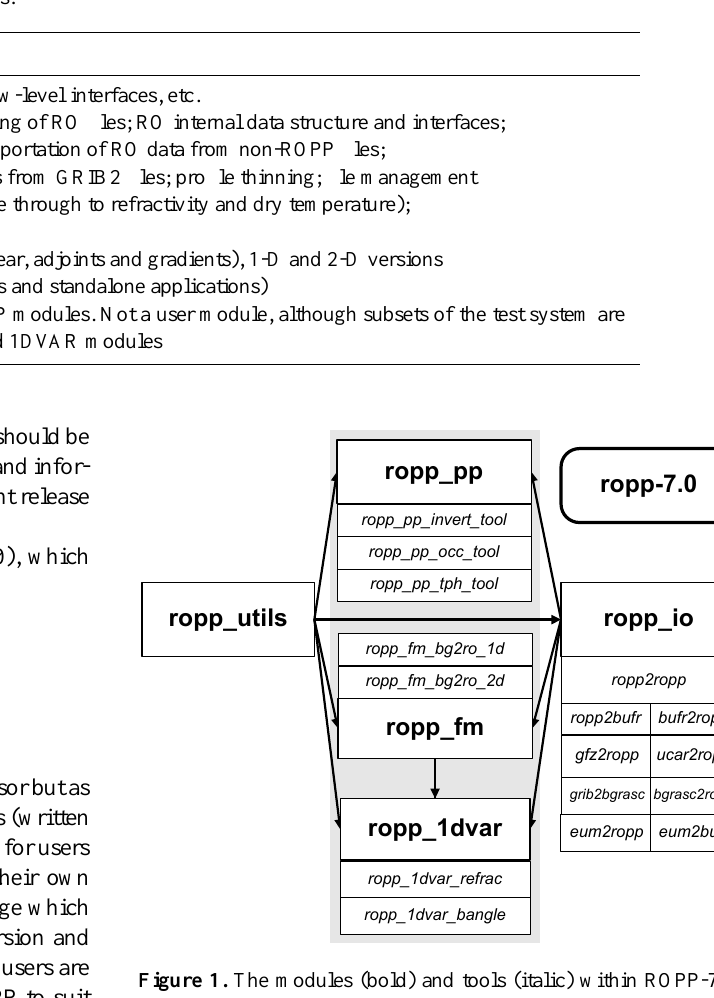
Table 1. ROPP-7.0 modules and their main functionalities.